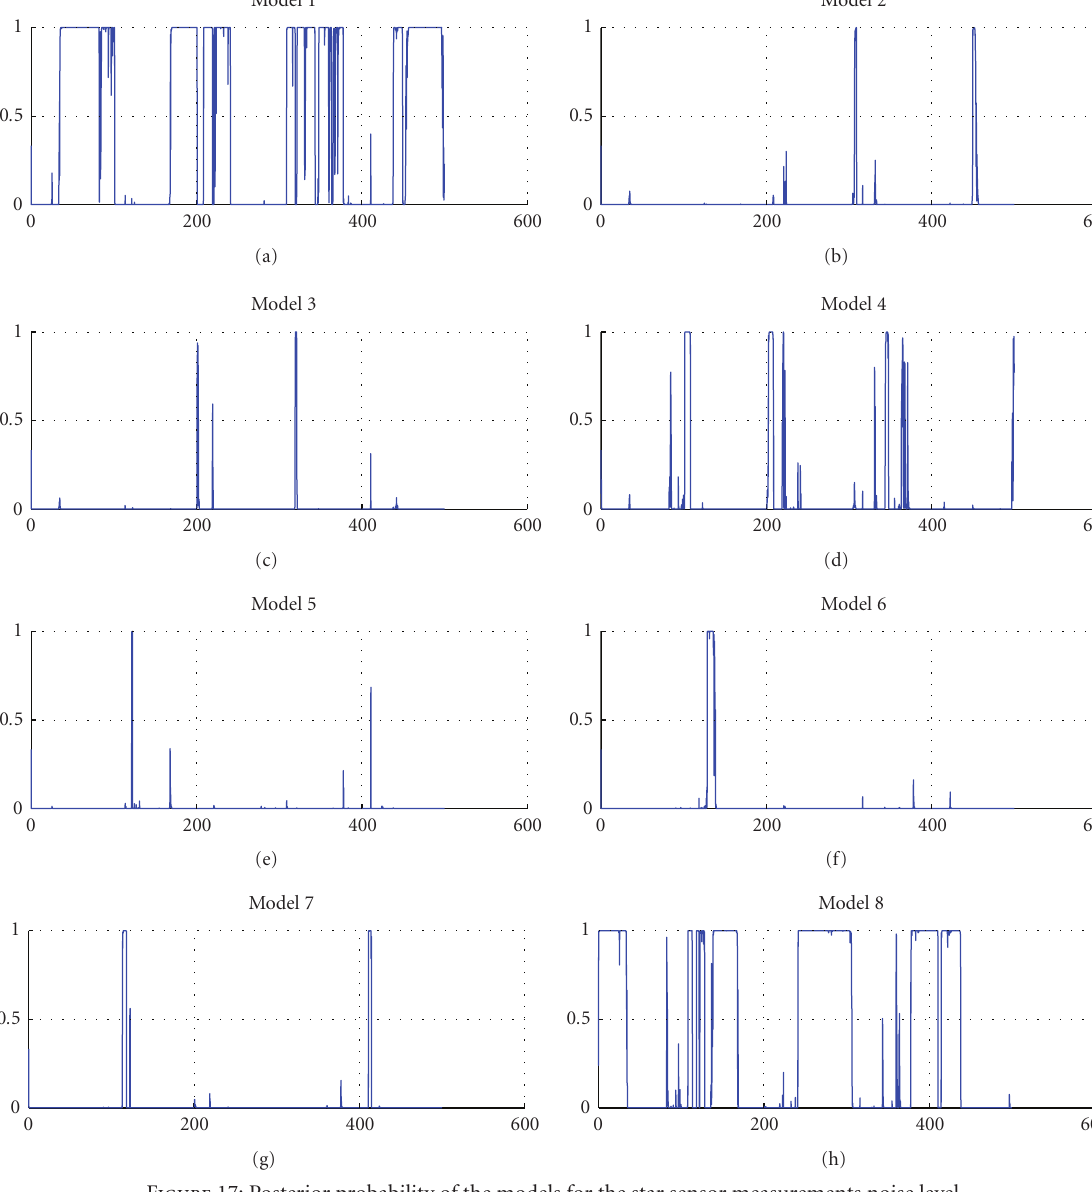
Figure 17: Posterior probability of the models for the star sensor measurements noise